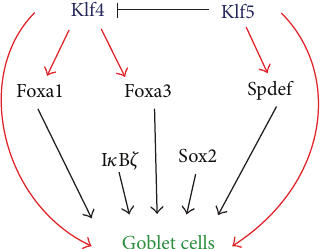
Figure 3: Hierarchical network of transcription factors regulating goblet cell development. Foxa1, Foxa3, and SPDEF, required for goblet cell development in other mucosal epithelia, are downregu- lated in Klf4 CN and Klf5 CN conjunctiva [16], placing Klf4 and Klf5 upstream of these factors in the network of factors governing goblet cell